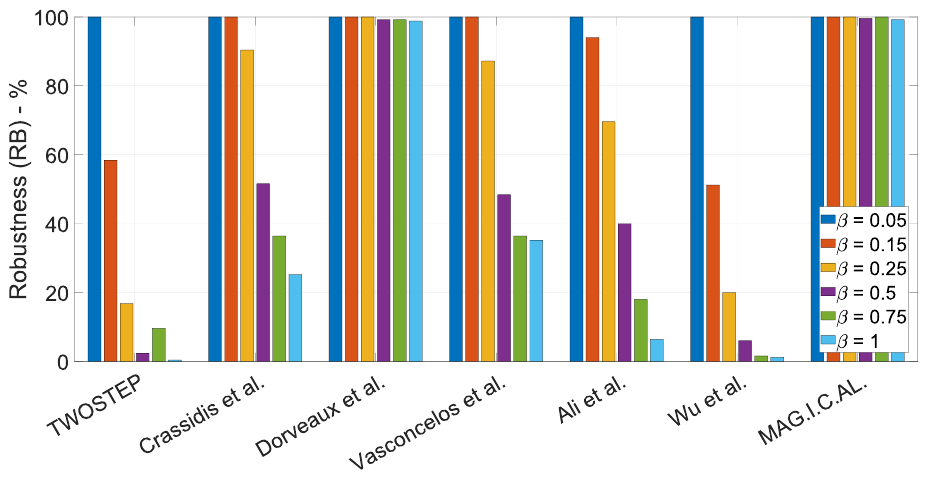
Figure 3. Performance characteristics of the presented algorithms for different values of β